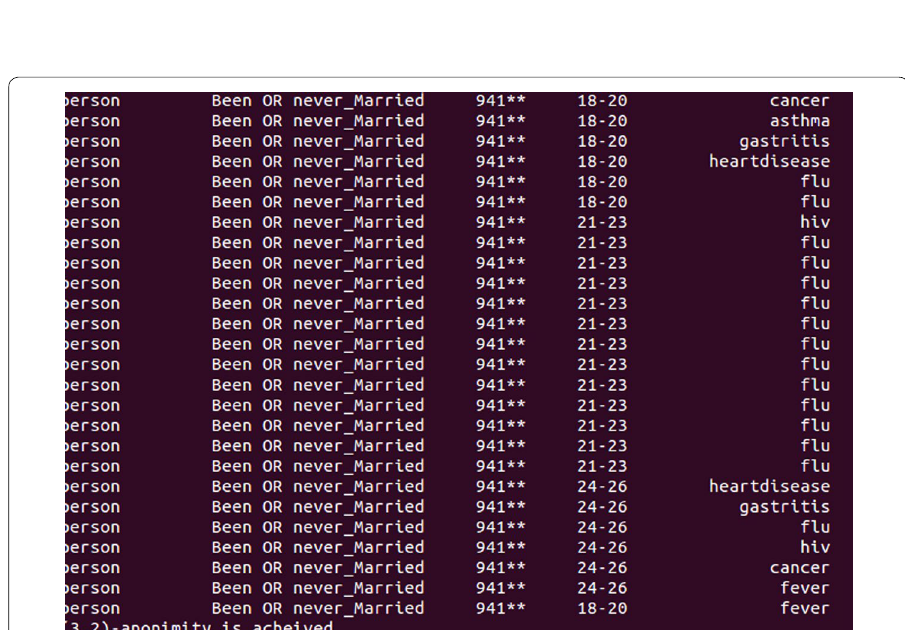
Fig. 10 Two level of anonymization with key value